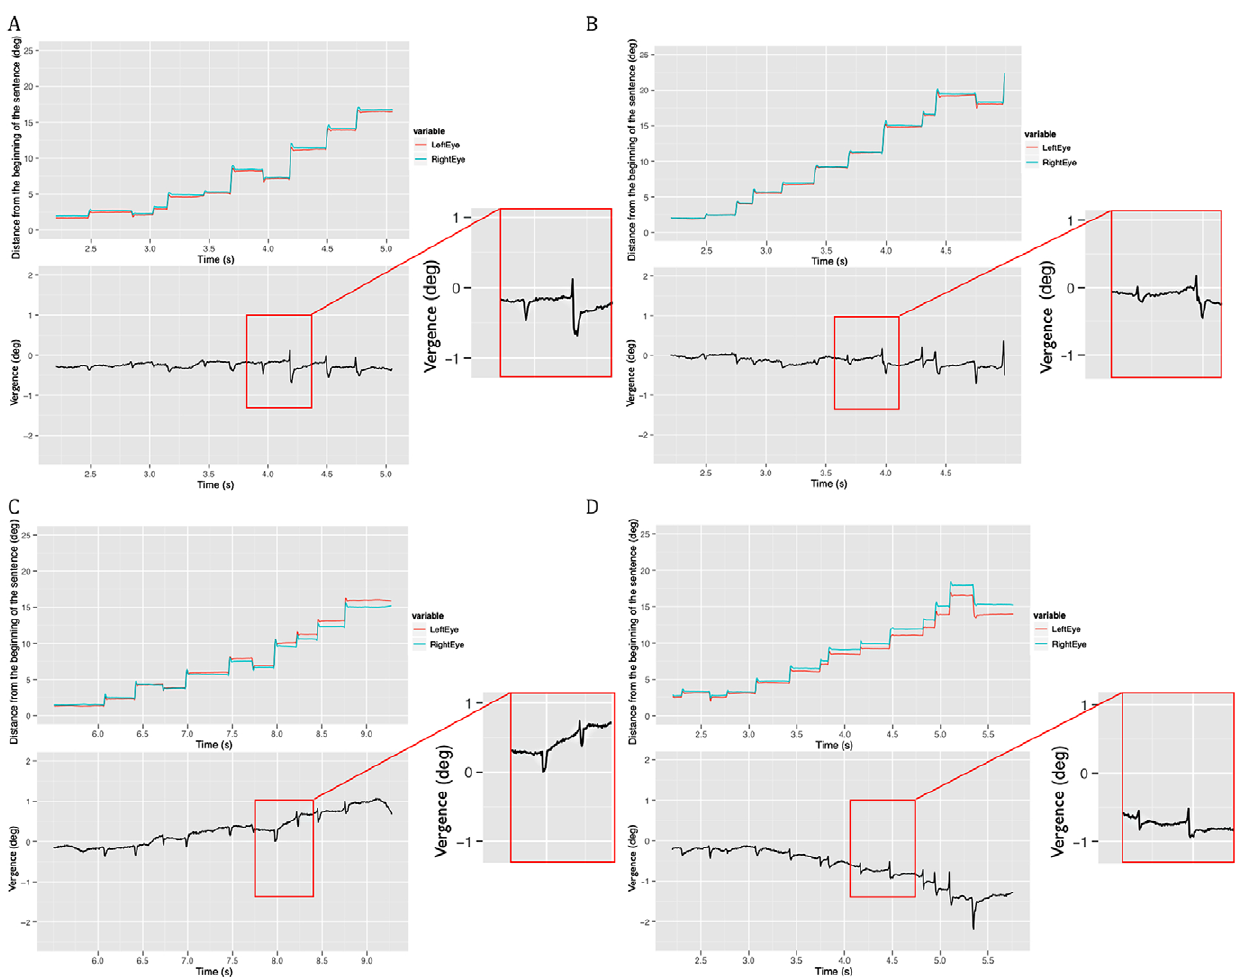
Figure 4. Left eye position, right eye position and disparity across time in single example trials in the different experimental conditions. In the top graphs, the red line represents the position of the left eye, the blue line represents the position of the right eye. The y axis represents distance from the beginning of the sentence and the x axis denotes time elapsed since the beginning of the trial (note that subjects were asked to hold fixation on the first word in the sentence for a few seconds; this time as been truncated and the plot represents only saccades and fixations associated with normal reading). In the bottom graph, the black line represents vergence of the two eyes; positive values denote convergence and negative values denote divergence. The insert enlarges the view of a series of two saccades. Panel A shows a trial in the monocular cue condition, panel B shows a trial in the normal condition, panel C shows a trial in the congruent condition and panel D shows a trial in the incongruent